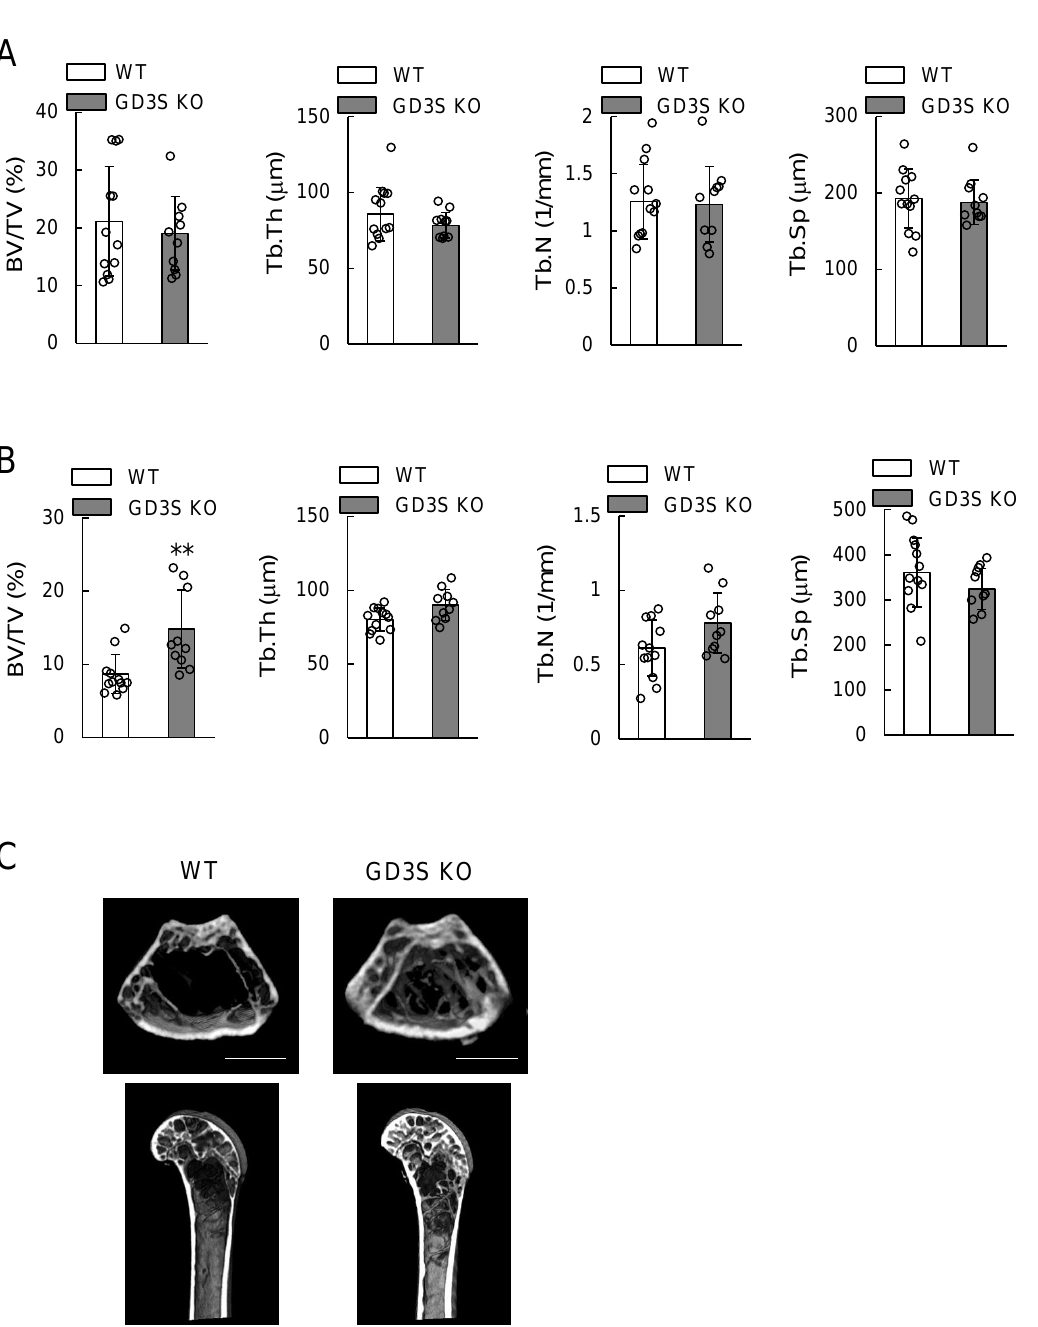
Figure 4. Attenuation of loss of femoral cancellous bone mass with aging in GD3S KO mice. Analysis of bone densitometry of the distal region of the femur in wild type (WT) and GD3S KO mice by three-dimensional micro-computed tomography (3D- µ CT). ( A ) 15-week-old mice (male, n = 12 for WT, n = 10 for GD3S KO). ( B ) 40-week-old mice (male, n = 12 for WT, n = 10 for GD3S KO). Bone volume / total volume (BV / TV, %), trabecular thickness (Tb.Th, µ m), trabecular number (Tb.N, 1 / mm), and trabecular separation (Tb.Sp, µ m) are presented. ( C ) Representative µ CT images of femur in WT and GD3S KO mice at 40 weeks old. Results of WT mice (left) and GD3S KO mice (right) are shown. The scale bars are 1000 µ m. Data are expressed as mean ± SD. The double asterisks (**) indicate p <